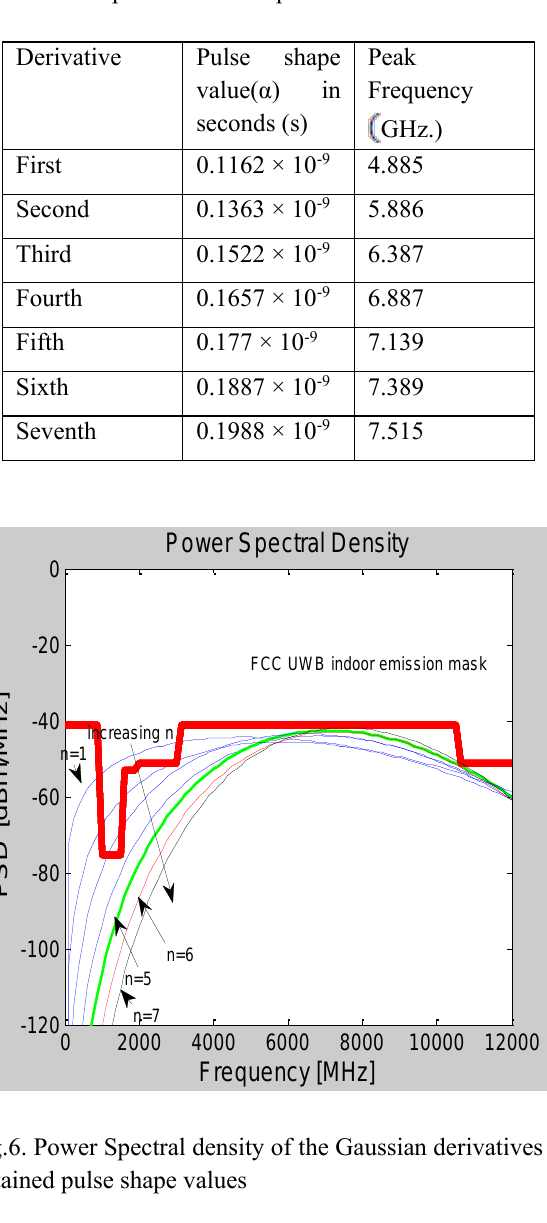
Table 2. Optimal Pulse shape factors values